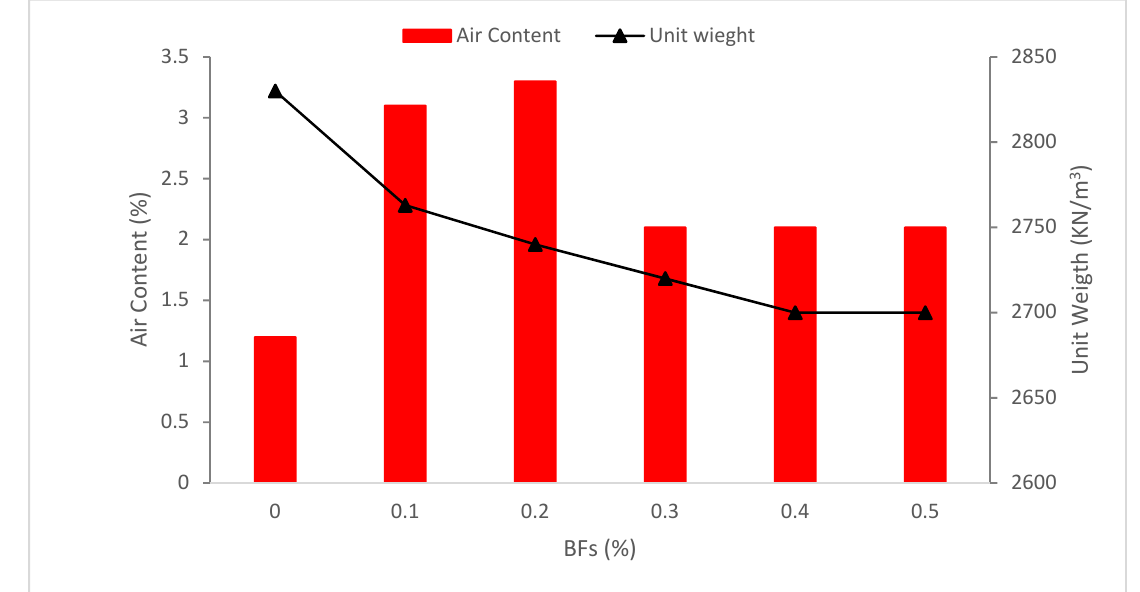
Figure 5. Air Content and Unit Weight: Data Source [61].